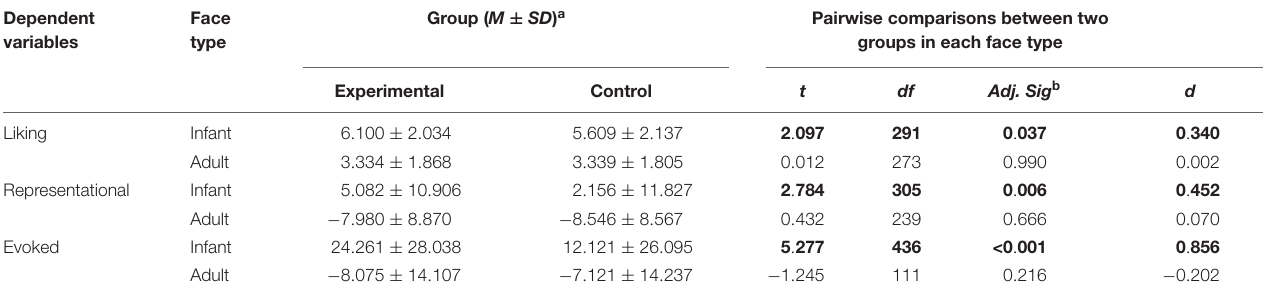
TABLE 4 | Descriptive statistics and pairwise comparisons ( n =